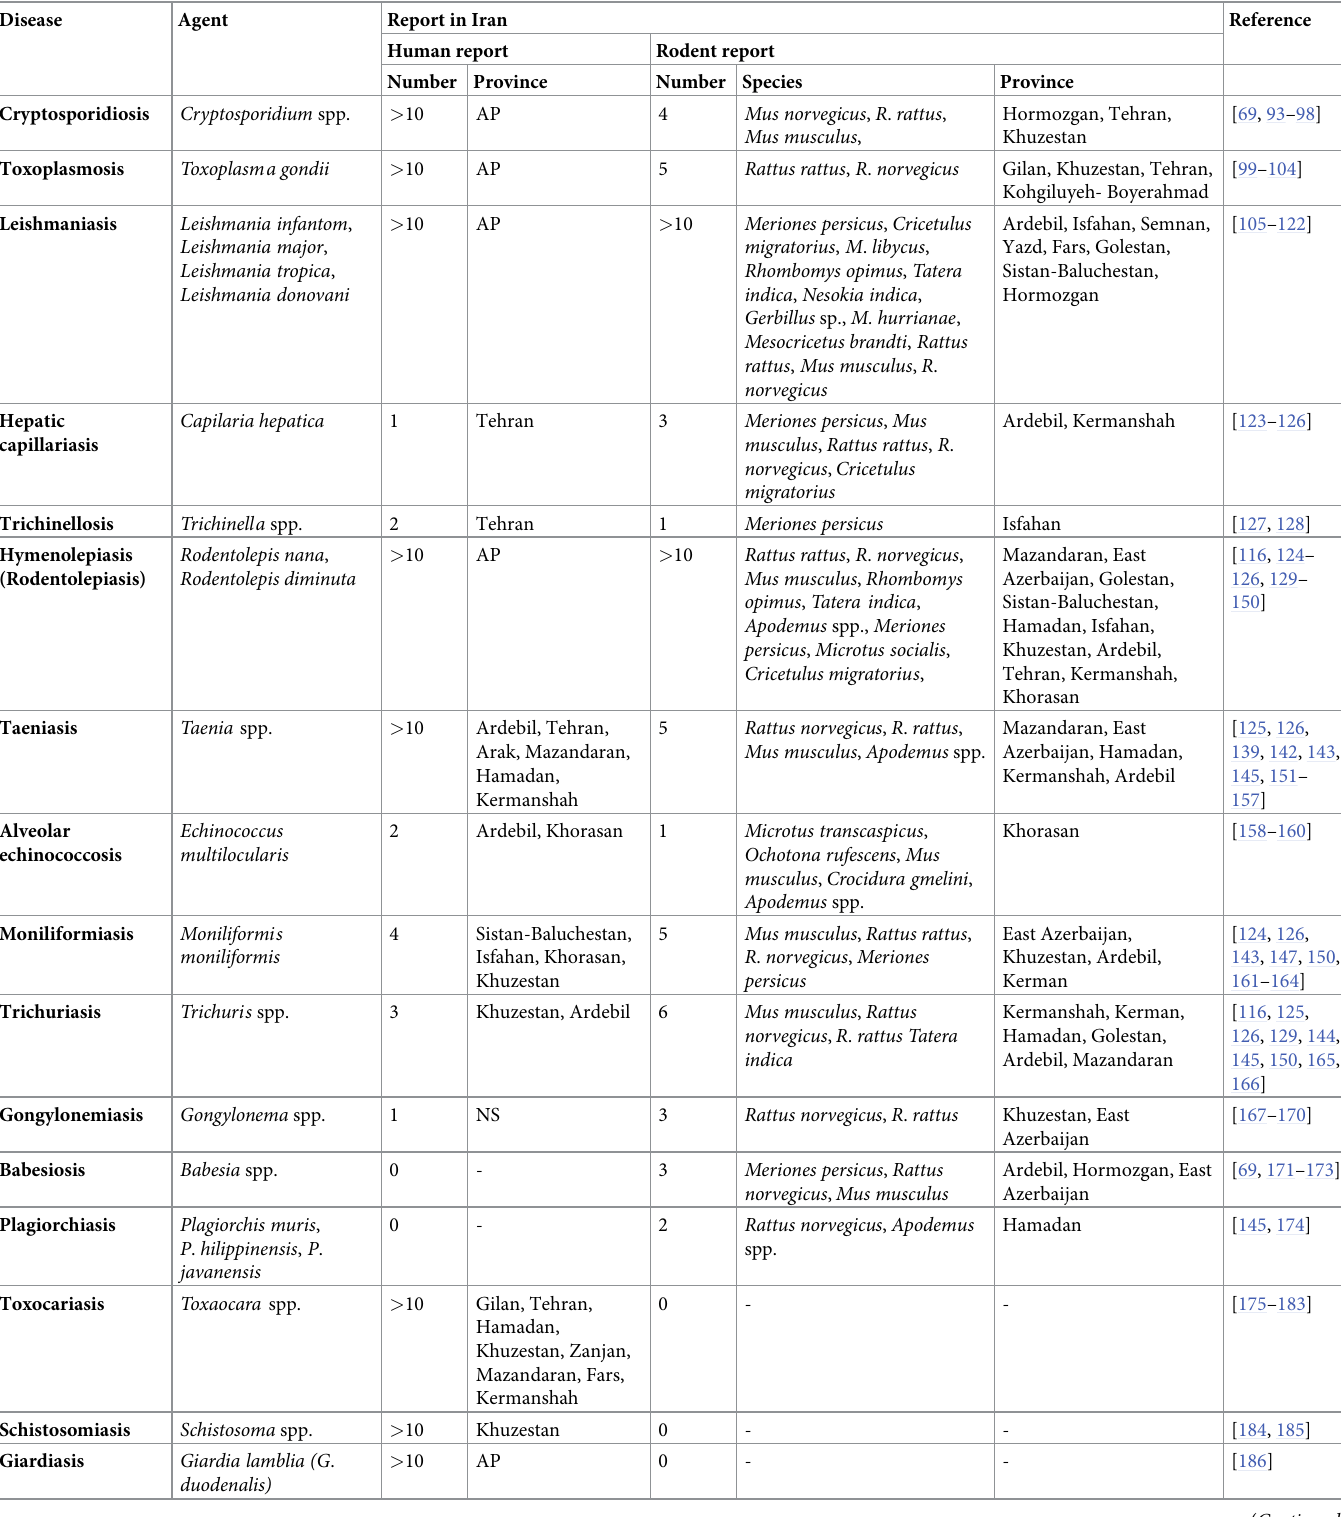
Table 3. Parasitic rodent-borne diseases reported in Iran.